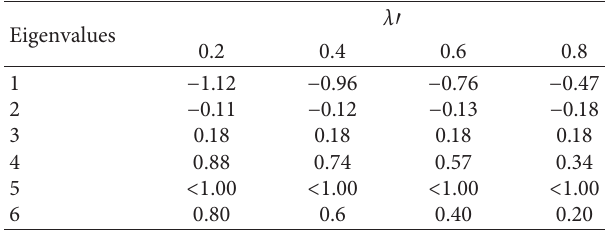
Table 3: Eigenvalues of J ∗